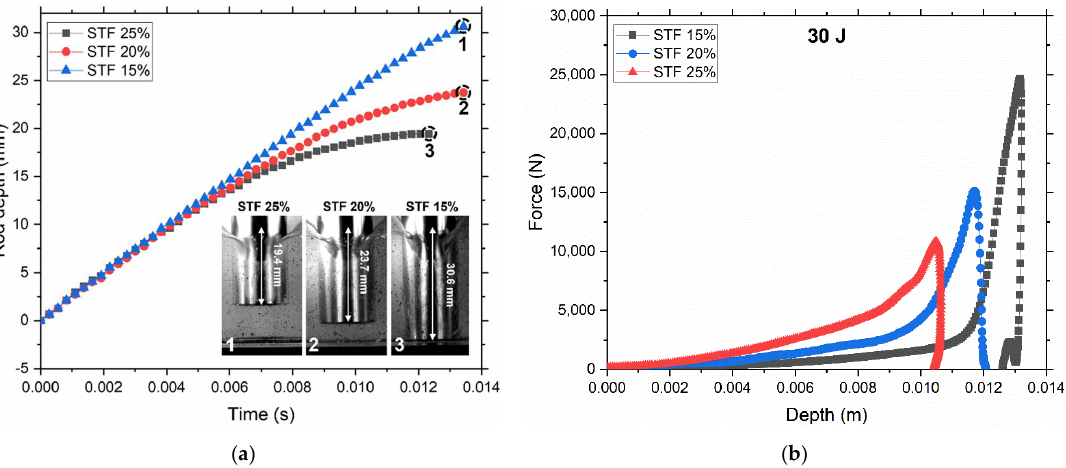
Figure 6. Change in impactor depth for two types of impact tests and the resemblance between them. ( a ) Rod depth against time during speed camera impact test. The speed of the rod before the impact ν 0 = 2.4 m/s. Photographs from the speed camera when the rod is completely stopped (19.4 mm for STF 25%, 23.7 mm for STF 20%, and the rod hit the bottom for STF 15% at 30.6 mm depth). Recording of whole tests is shown in Supplementary Video S1. ( b ) Calculated force-displacement (depth) profiles for drop weight test at 30 J. Displacement was calculated from the integration of the velocity-time plot, which in turn was obtained by integrating the force-time plot divided by the impactor